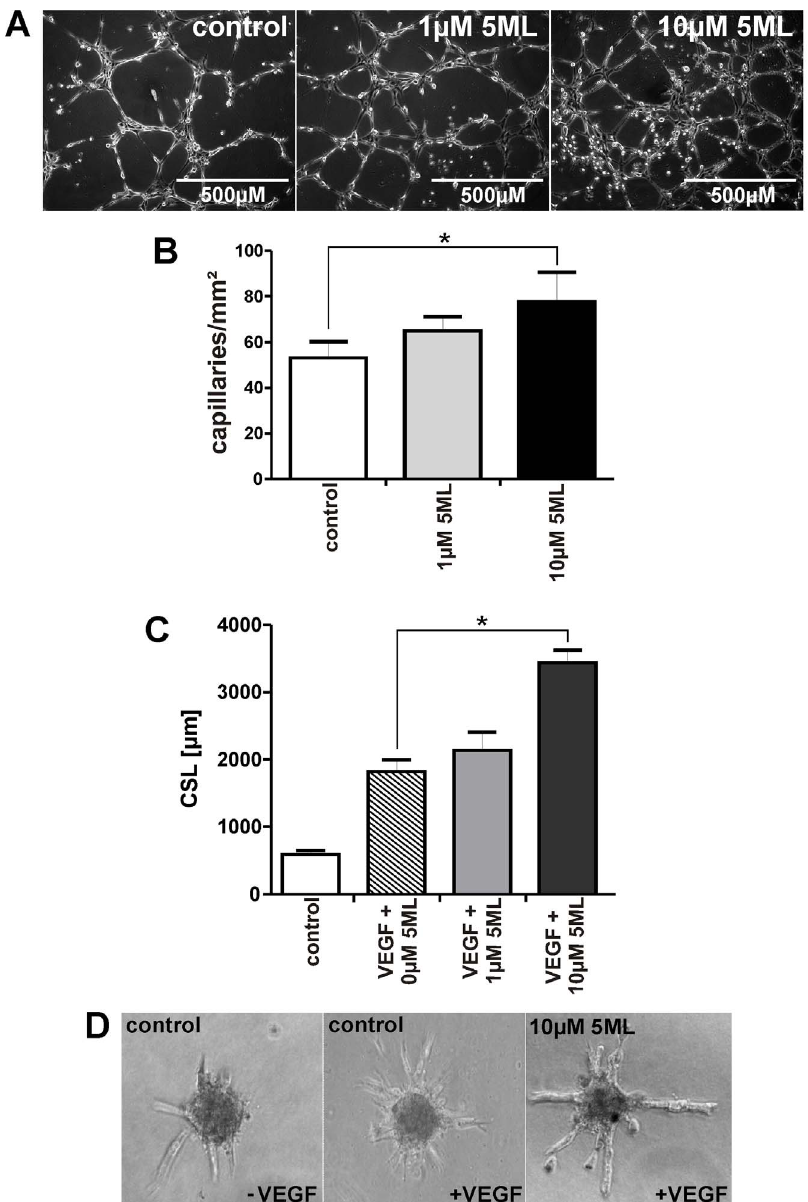
Figure 1. 5ML promotes capillary tube formation and angiogenic sprouting of human endothelial cells in a dose dependent manner . Figure 1A: Effects of increasing concentrations of 5ML on human endothelial cells were analyzed in a capillary tube formation assay in matrigel (magnification: 100 6 ). Figure 1B: Numbers of capillaries per mm 2 were determined 6 hours after incubation with 1 and 10 m M 5ML. Figure 1C: Spheroids of HUVECs were stimulated with 50 ng/mL VEGF and different concentrations of 5ML or DMSO as solvent control. Cumulative sprout length (CSL) was analyzed 24 hours after stimulation (Figure 1D). All experiments were performed in triplicates. Asterisks indicate significant differences (* p , 0.05) compared to the corresponding controls.